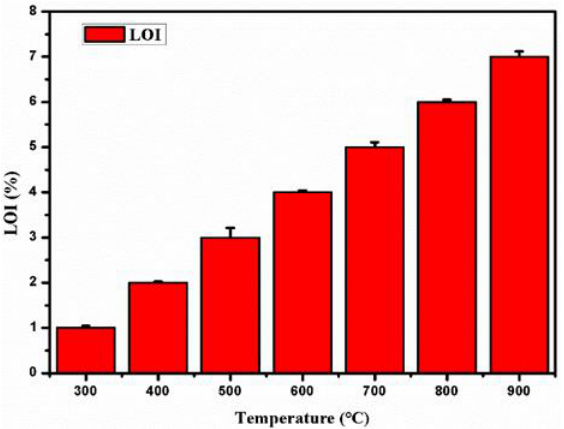
Figure 4. Relationship between loss of fly ash and heating temperature.